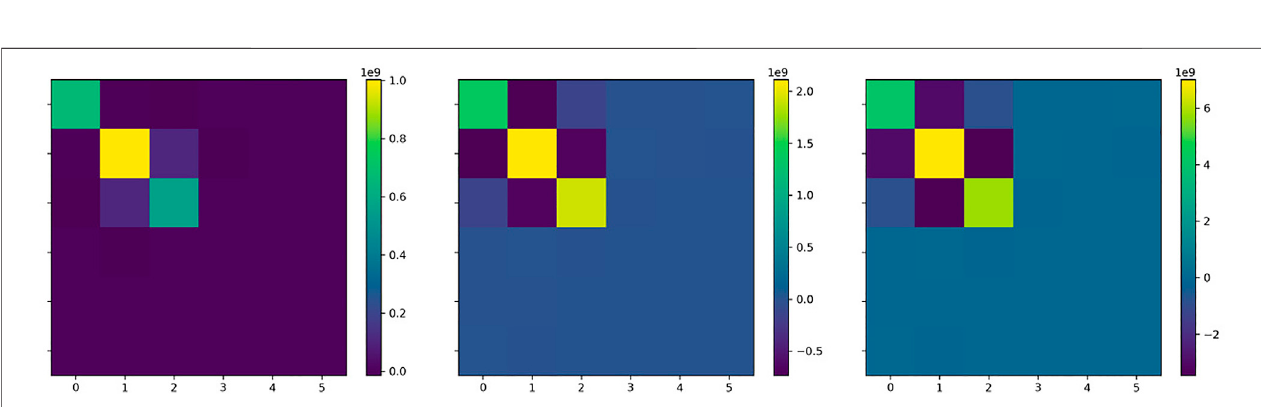
FIGURE 3 | Metric tensors shown here for 6 parameter rigid transformations. Left: origin at the center, middle: origin half way, right: origin at the corner.